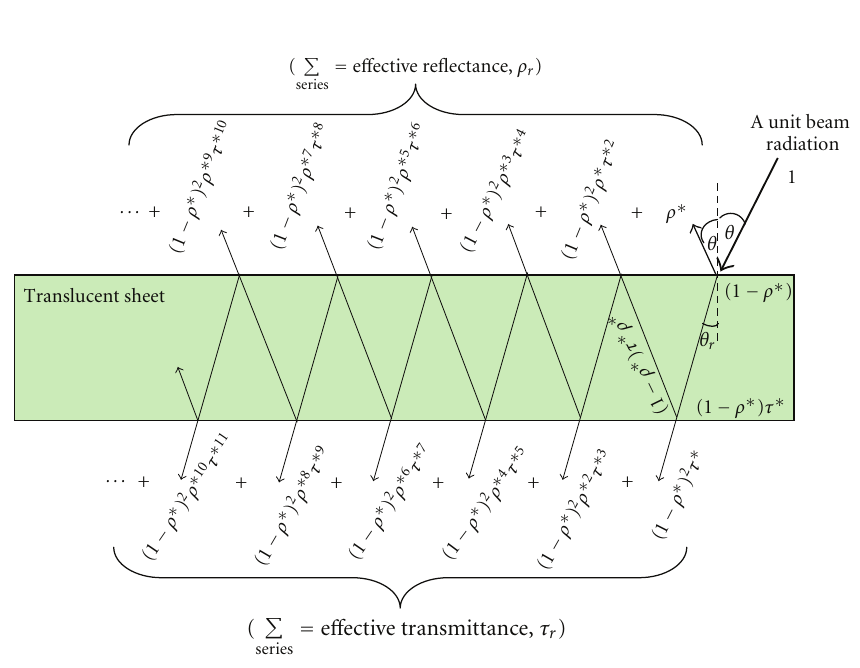
Figure 2: Tracing of a unit beam radiation through a translucent sheet to illustrate the concept of the e ff ective reflectance and e ff ective transmittance of the